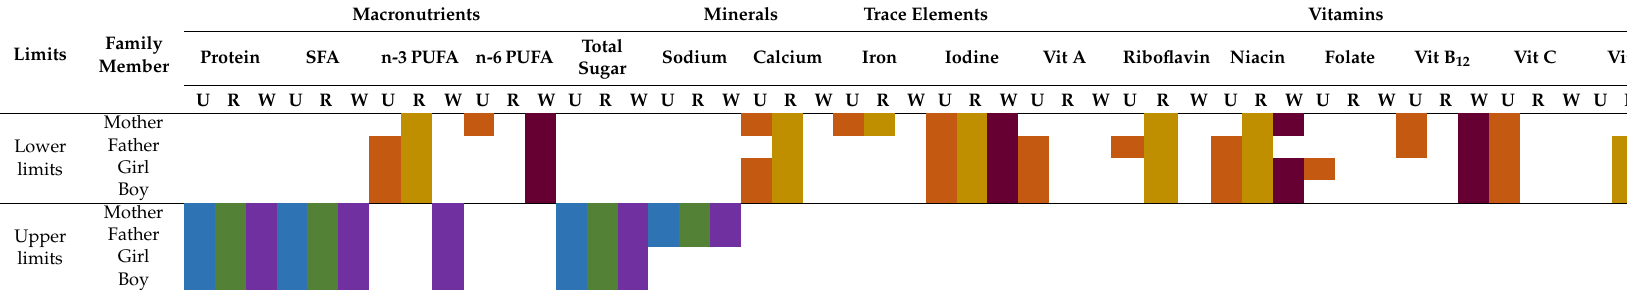
Table 3. Nutrients that work as active constraints on the cost of Ghanaian food baskets. A shaded cell indicates an active constraint for the UFB (U; lower limit, orange; upper limit, blue), the RFB (R; lower limit, beige; upper limit, green) or the RWFB (W; lower limit, brown; upper limit, violet). Lowering the lower limits and increasing the upper limits of active constraints would result in reduced cost. SFA, saturated fatty acids; PUFA, polyunsaturated fatty acids; Vit,